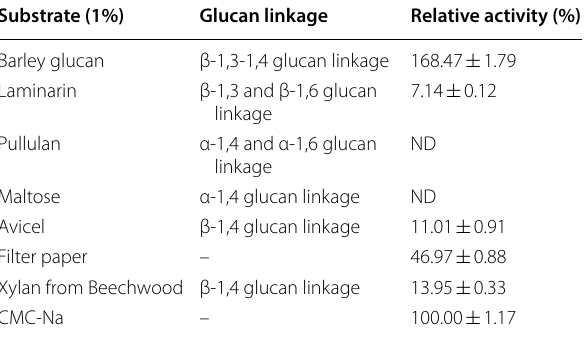
Depending on the substrate, activity was determined under optimal conditions. Enzyme activity using substrate of 1% CMC-Na was set of 100%